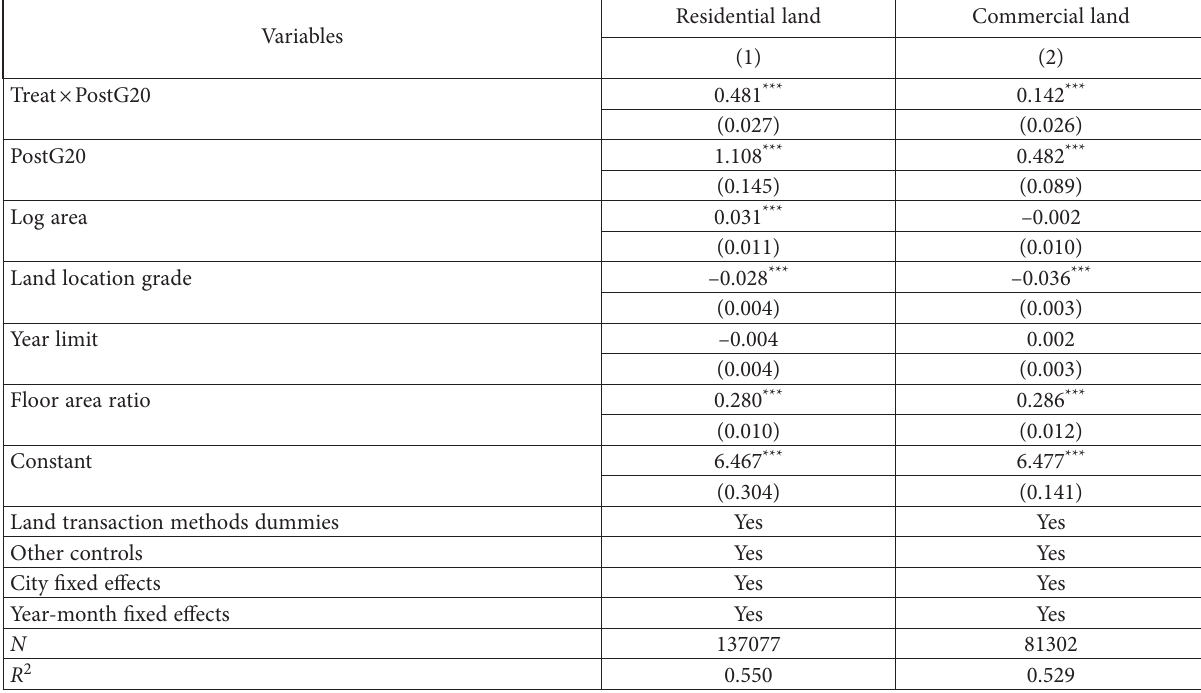
Table 5. Heterogeneous effect of hosting the G20 Summit across residential and commercial land